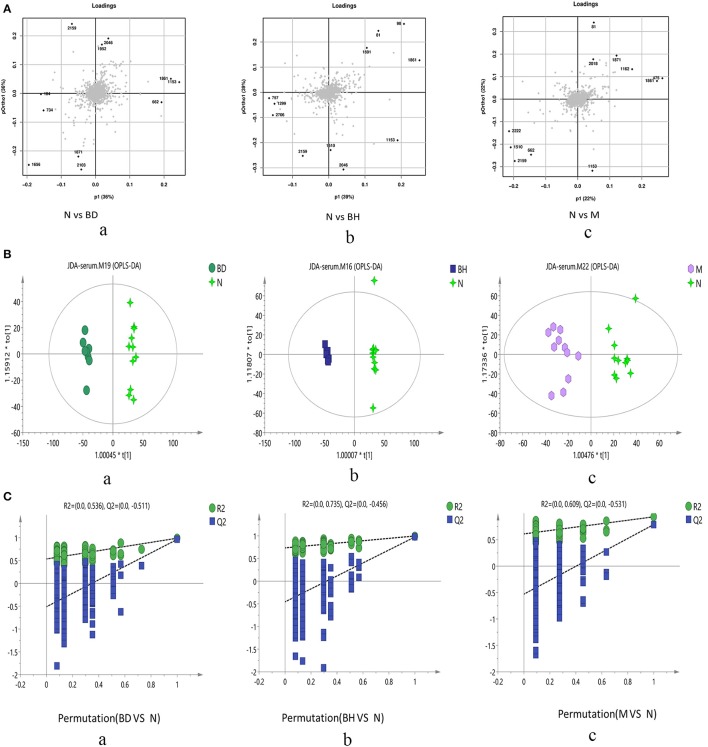
Score plots of metabolite levels in a serum sample. OPLS-DA score plots of the serum metabolic profile (A): (a) N vs. BD, (b) N vs. BH, and (c) N vs. M. Permutation score plots of serum metabolic profiles (B): (a) N vs. BD, (b) N vs. BH, and (c) N vs. M. Loading score plot of the serum metabolic profile (C): (a) N vs. BD, (b) N vs. BH, and (c) N vs. M. N denotes the control group, M represents the APP/PS1 transgenic group, BD denotes the 50 mg/kg OMO-treated group, and BH represents the 100 mg/kg OMO-treated group.